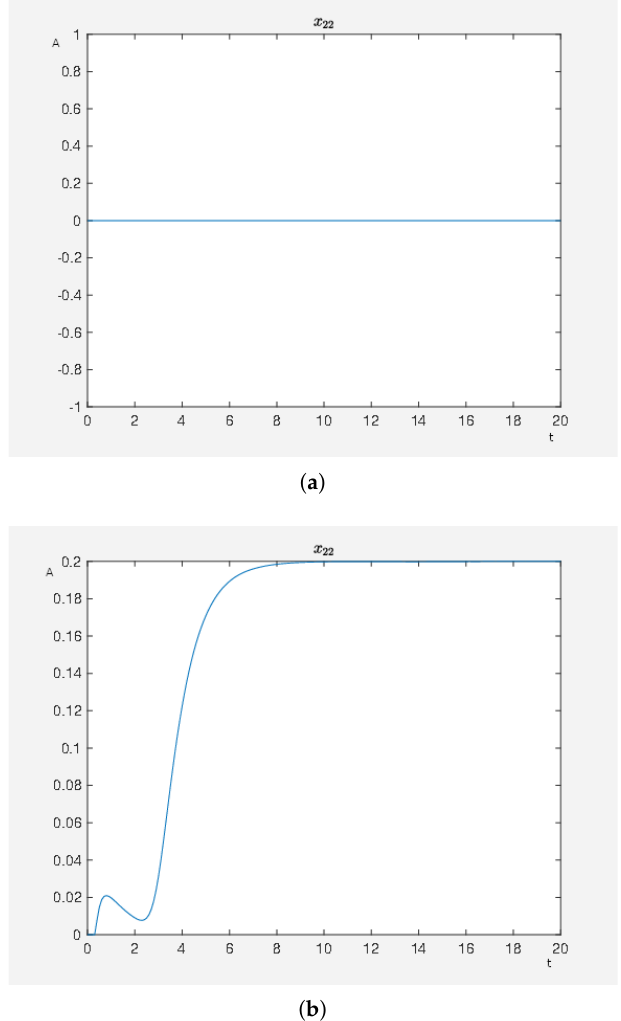
Figure 7. On the abscissa, we have the time (t) and on the ordinate the activity level (A) of the ERK1/2 dim 3P in the forth experiment: ( a ) with ζ 22,3 = 1; and ( b ) with ζ 22,3 = 0.8 in model (2.1) of the Supplementary Materials, which demonstrates how to adapt different capabilities of the external stimuli with respect to influencing the corresponding